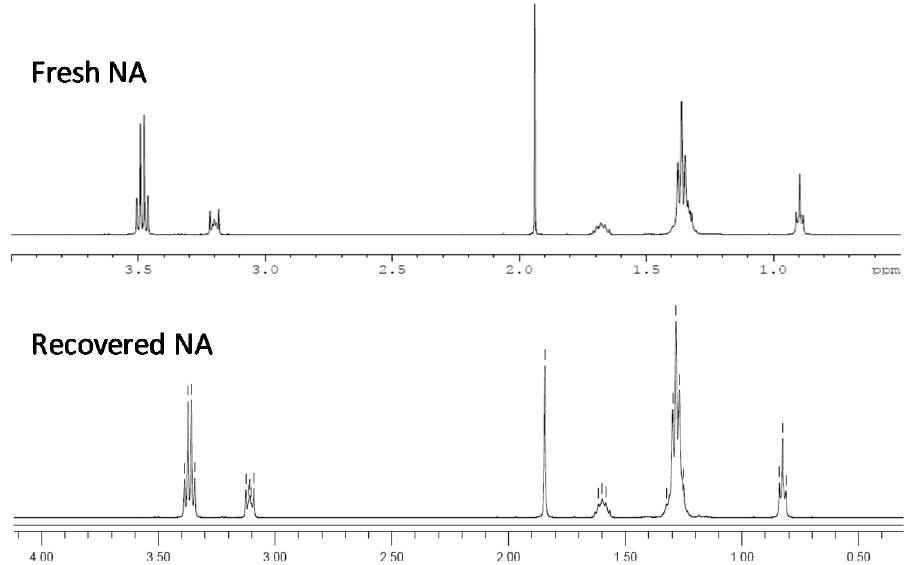
Figure 6. 1 H NMR spectra of fresh NAand recovered NA ILs.